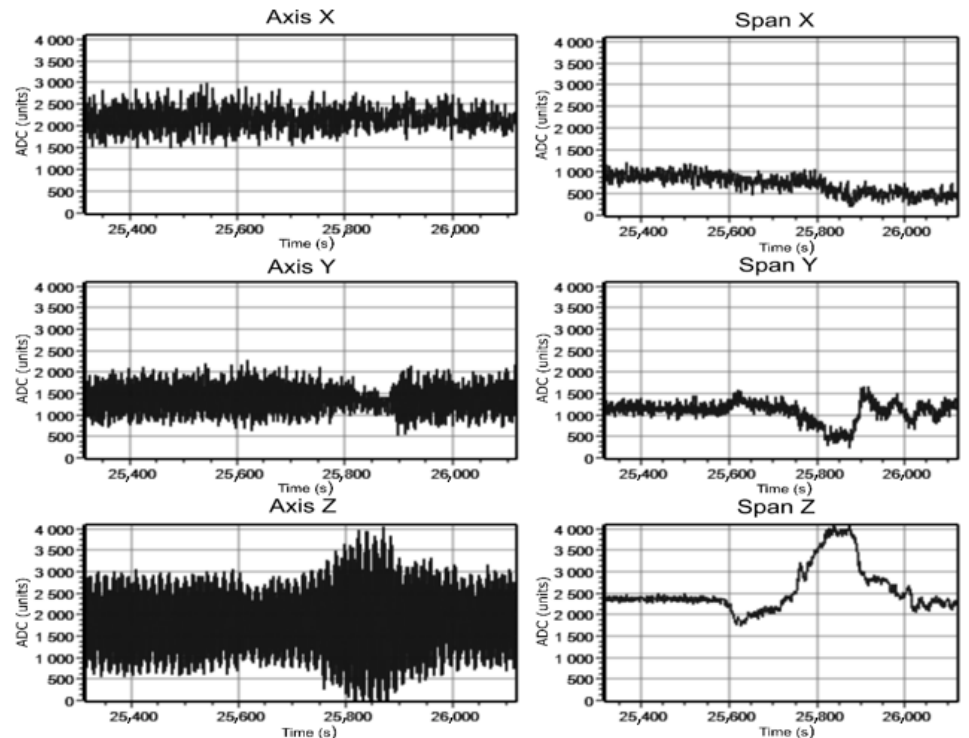
Figure 20. Changes in signals during live cable movement from bottom to top at 295 A current.